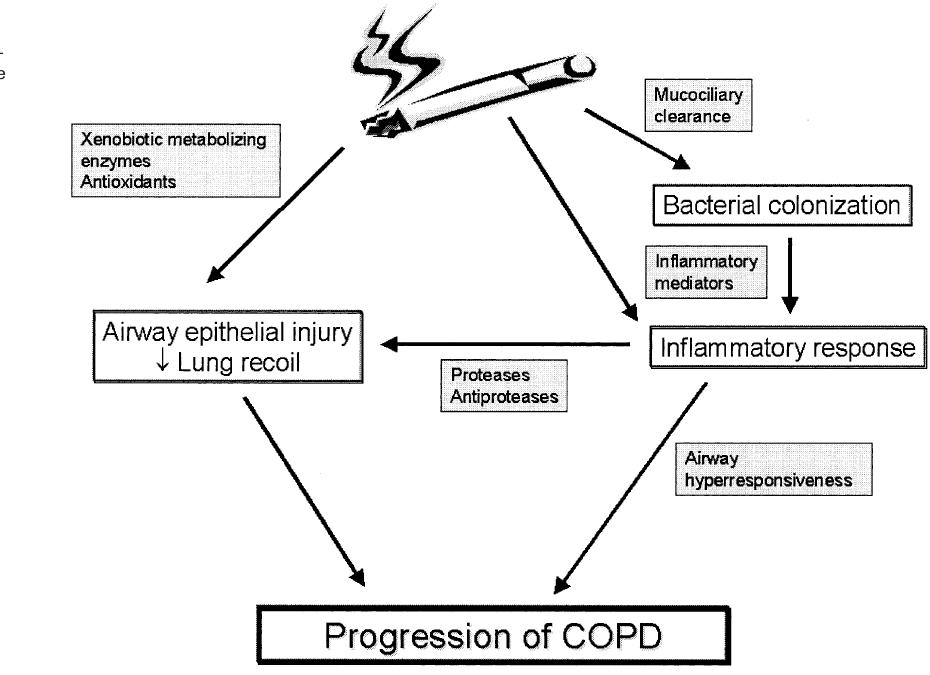
Summary of path- ways and possible candidate genes involved in the pathogenesis of